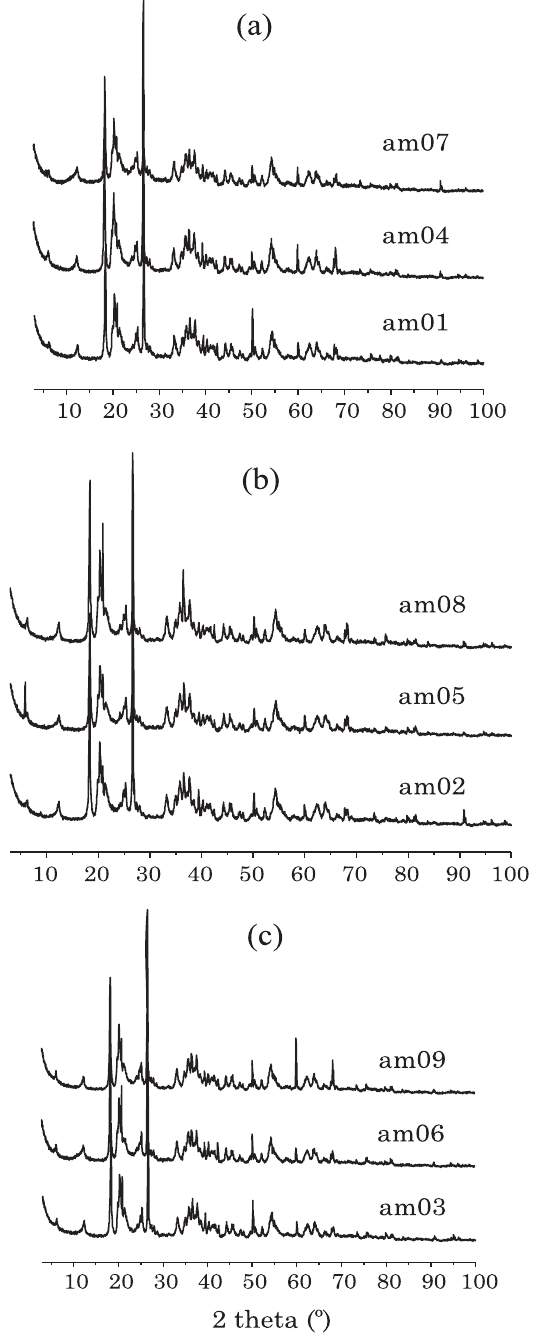
Figura 2. Difratogramas das nove amostras analisadas nos diferentes manejos e profundidades. Profundidades: (a) 0,0 – 0,20 m, (b) 0,20 – 0,40 m e (c) 0,40 – 0,60 m; em cada um dos gráficos, os difratogramas do inferior ao superior representam os manejos: PC, PM e PD,